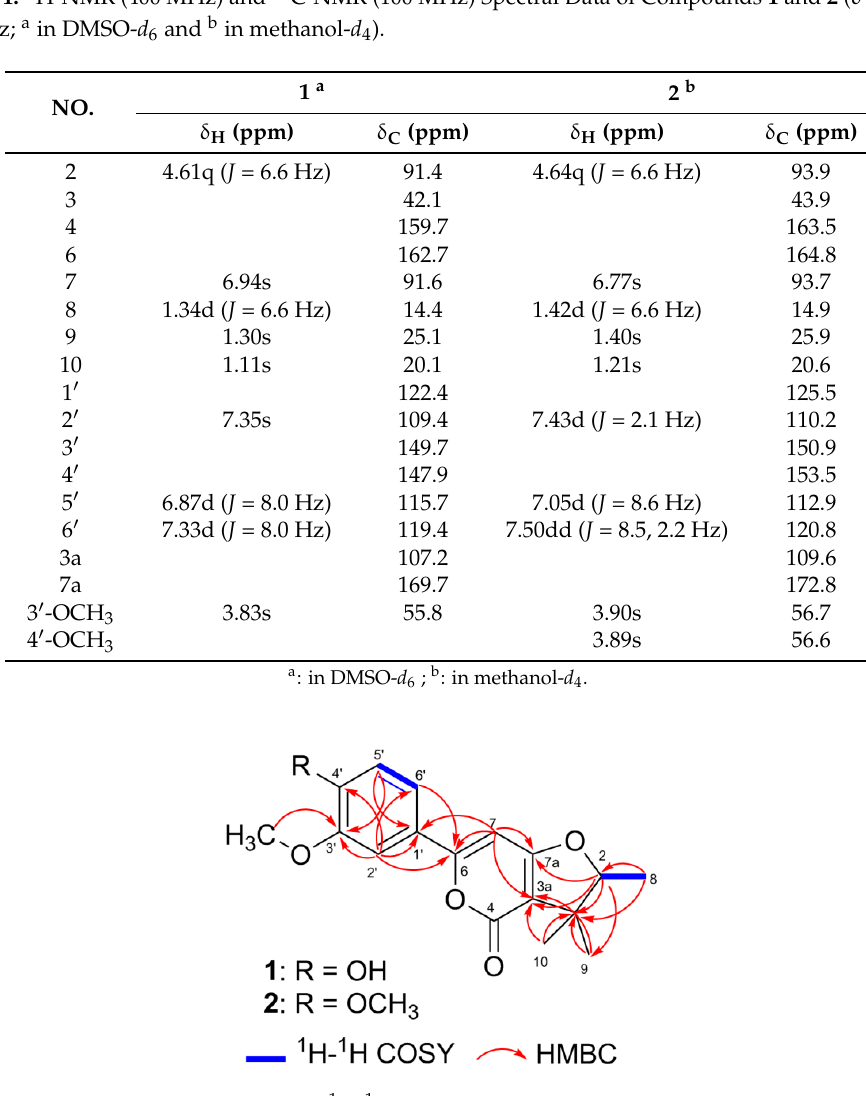
Table 1. 1 H-NMR (400 MHz) and 13 C-NMR (100 MHz) Spectral Data of Compounds 1 and 2 ( δ in ppm,